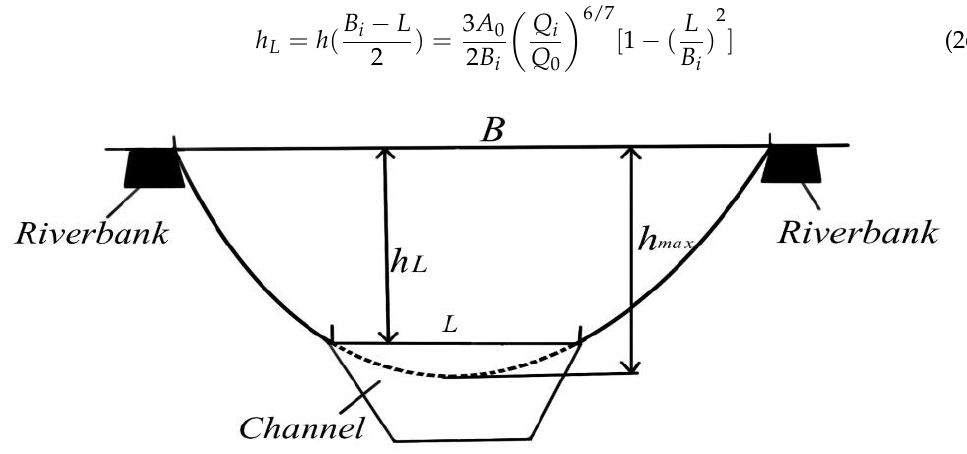
Figure 3. Sketch of the navigable depth.